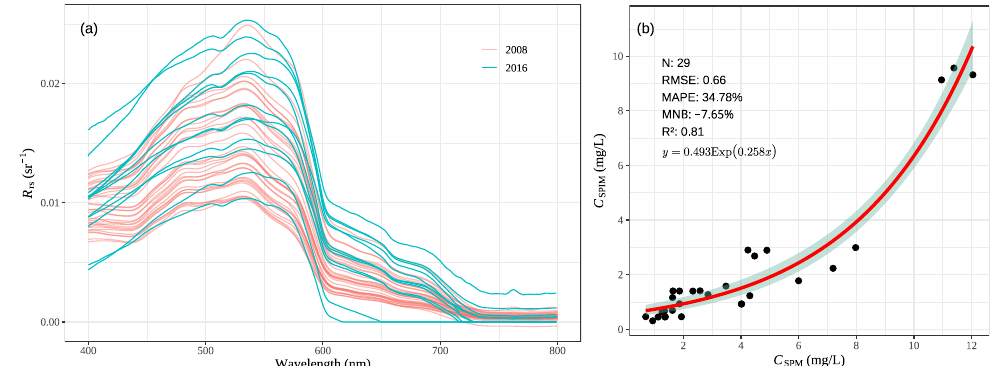
Figure 3. In situ measured spectra ( a ) and the relationship between C SPM and C SPIM ( b ) (the black dots show the in situ measured samples; the red line is the regression line, and the translucent green indicates a 95% confidence